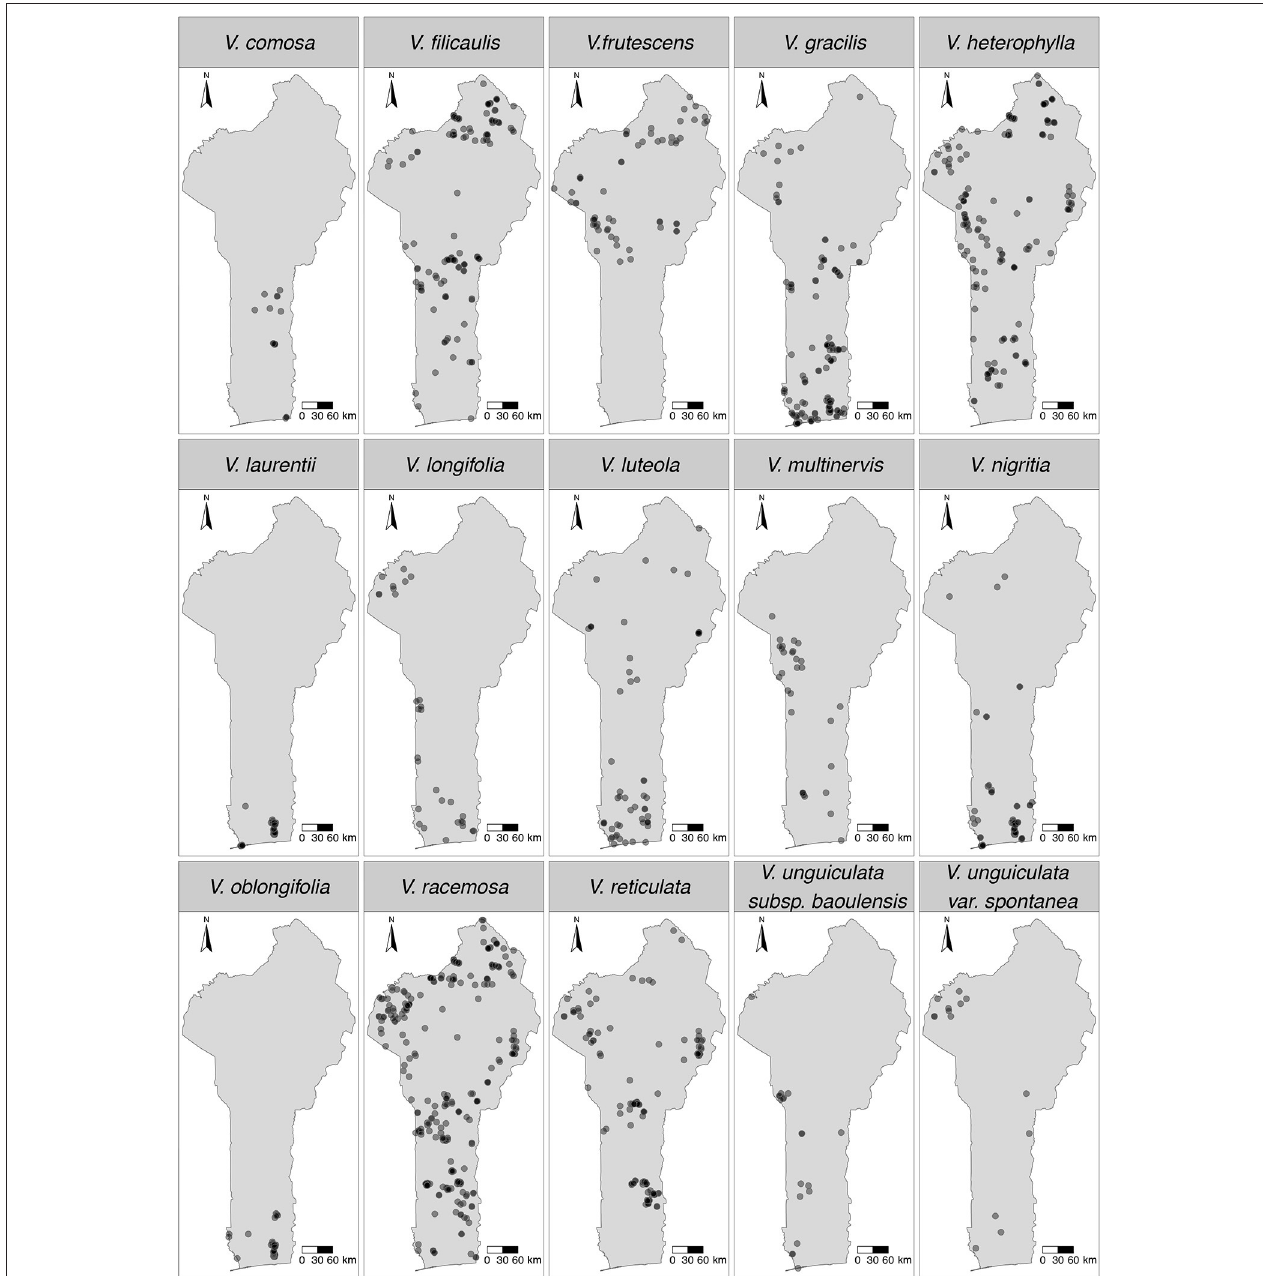
FIGURE 1 | Spatial distribution maps of the modelled 15 Vigna CWR taxa in